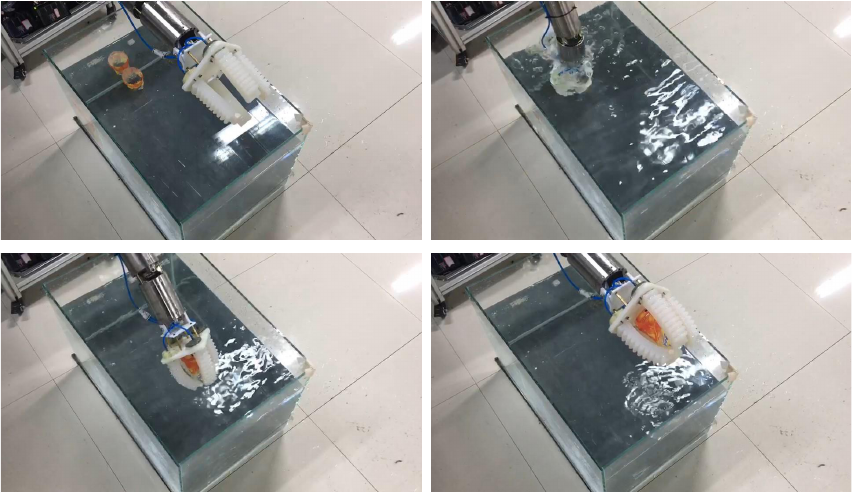
Figure 15. Experiment of SET3 in the underwater